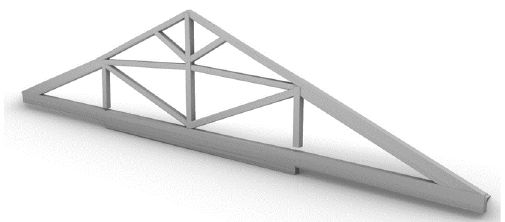
Figure 8: Basic 3D model